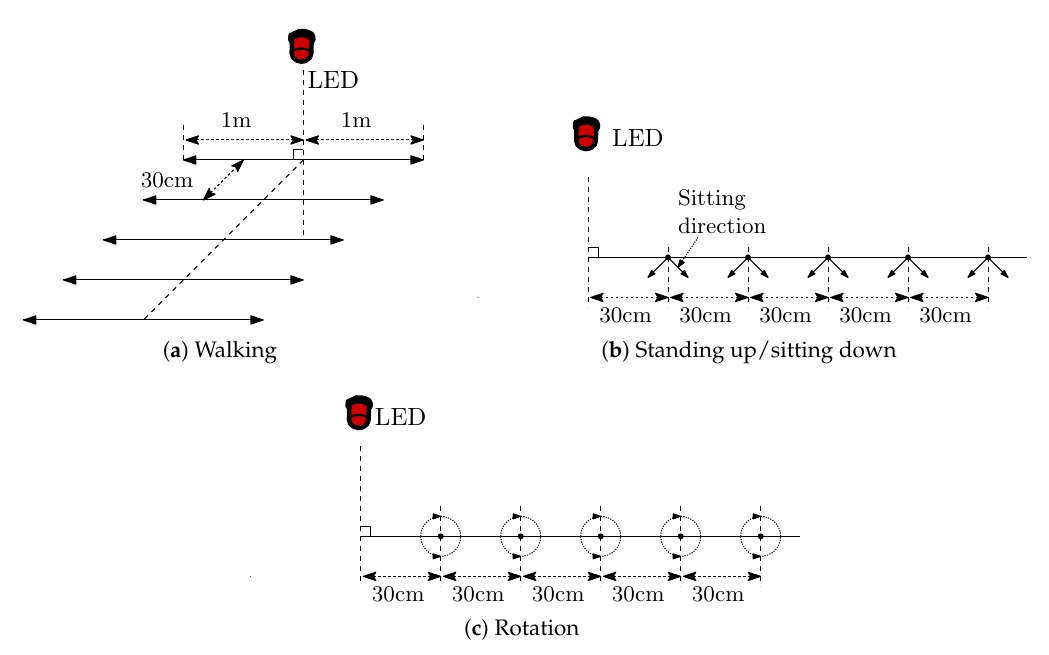
Figure 3. Scenarios for channel measurements.